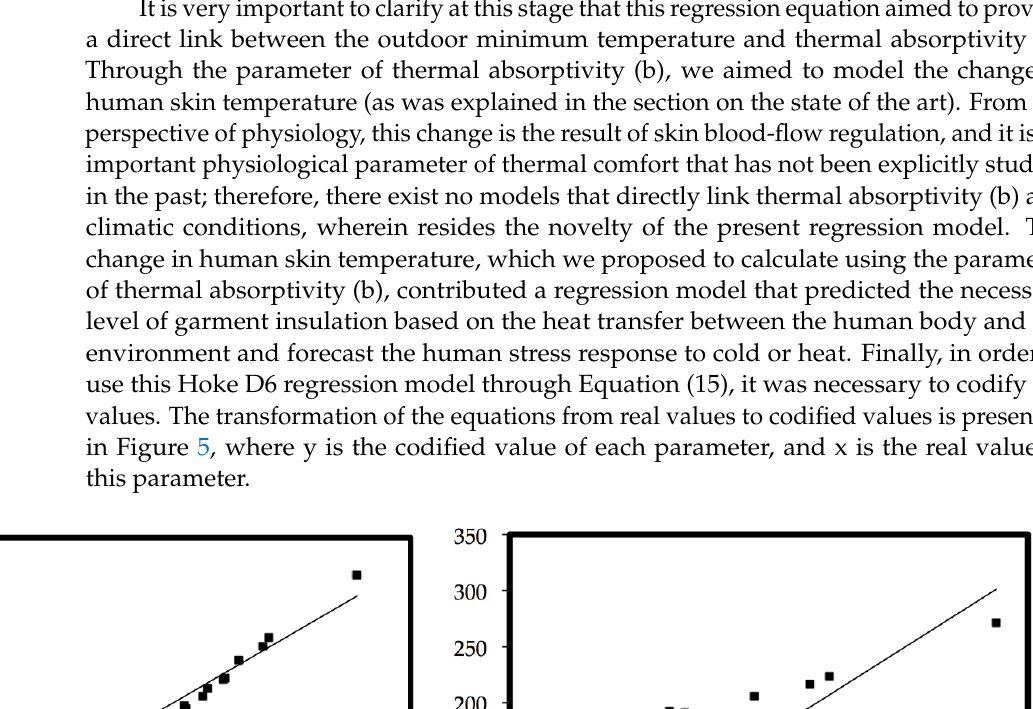
Figure 3. Test dataset comparison. Hoke D6 design model’s satisfactory fit to Kim et al . ’s model